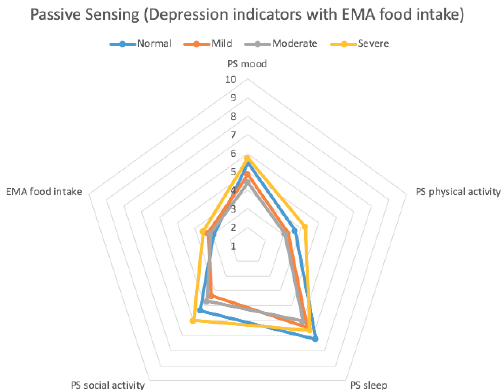
Figure 10. Averaged depression indicators with passive sensing.